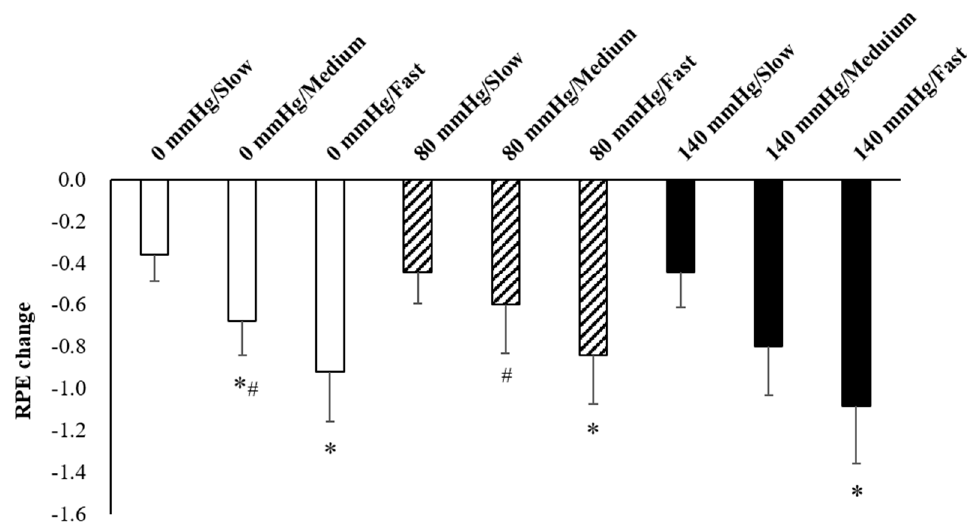
Figure 6. Responses of RPE to various pressure and rowing cadence conditions during the recovery period (mean ± SE). * Significantly different from low cadence under the same pressure. # Significantly different from 140 mmHg under the same cadence.